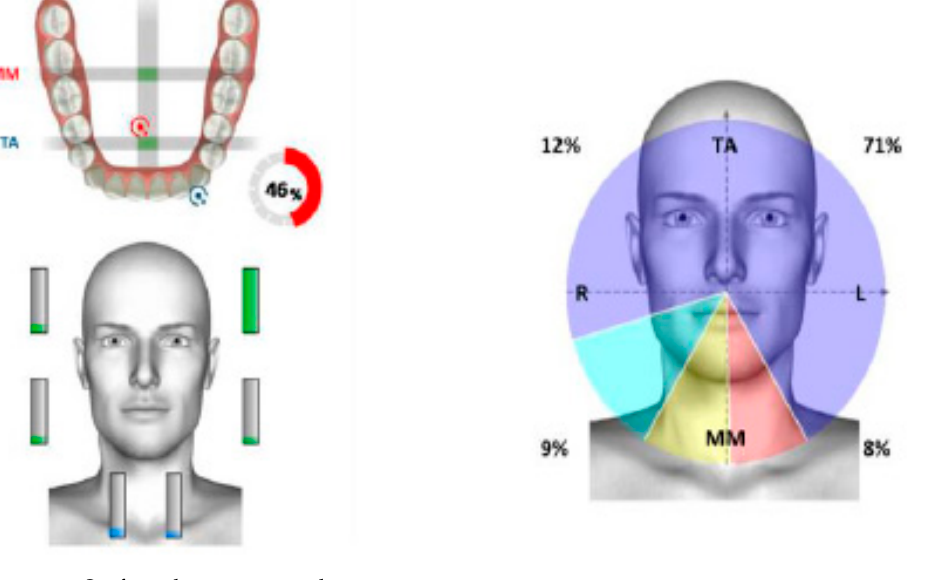
Figure 28. Surface electromyography.